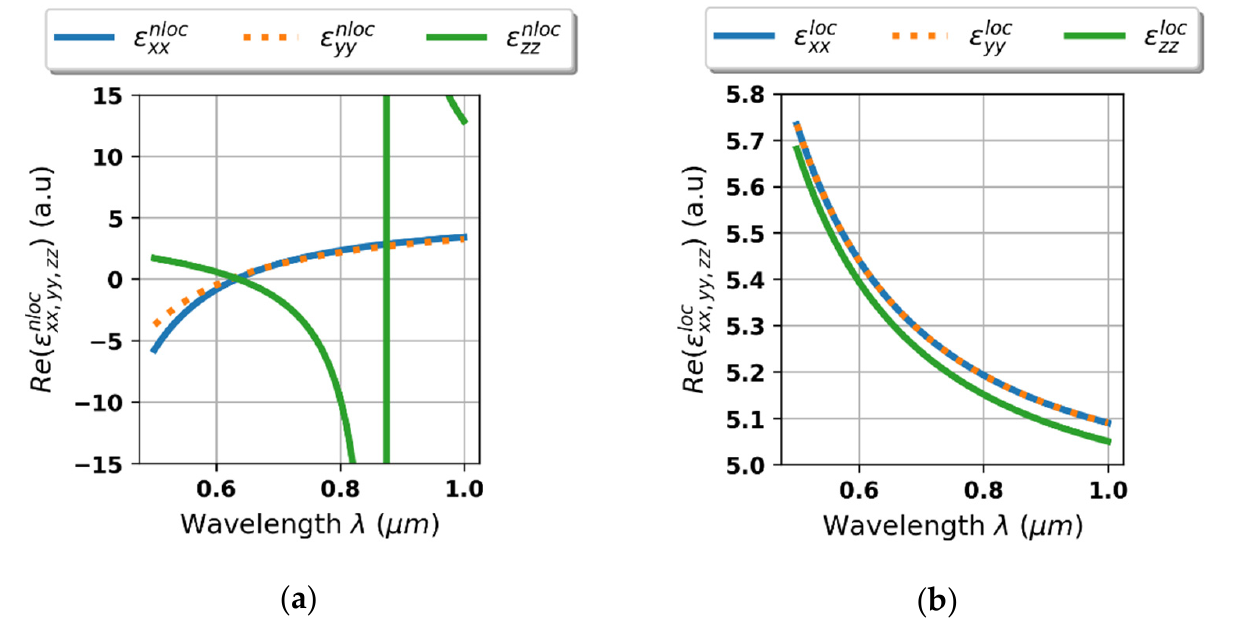
Figure 3. Real parts of effective permittivity tensor components of the HMM structure plotted vs. wavelength, calculated with non-local ( a ) and local ( b ) effective medium approach.